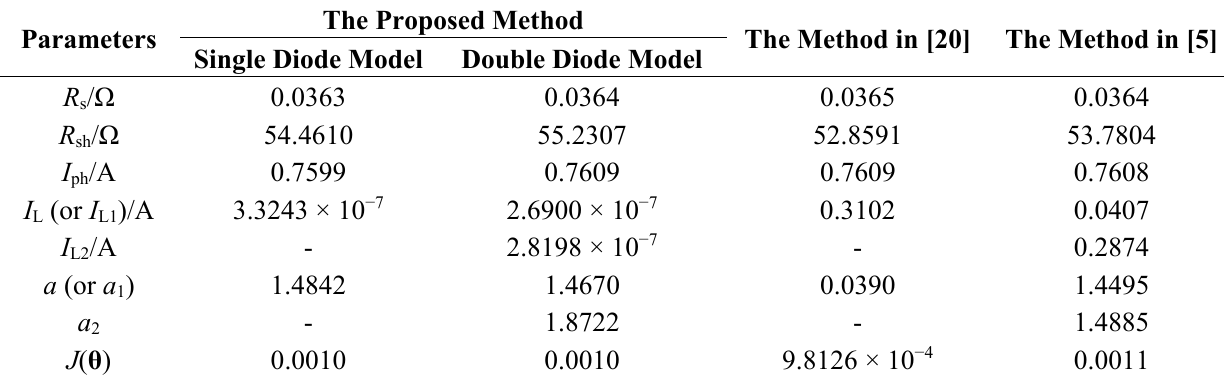
Table 6. Identified parameters after applying different methods.